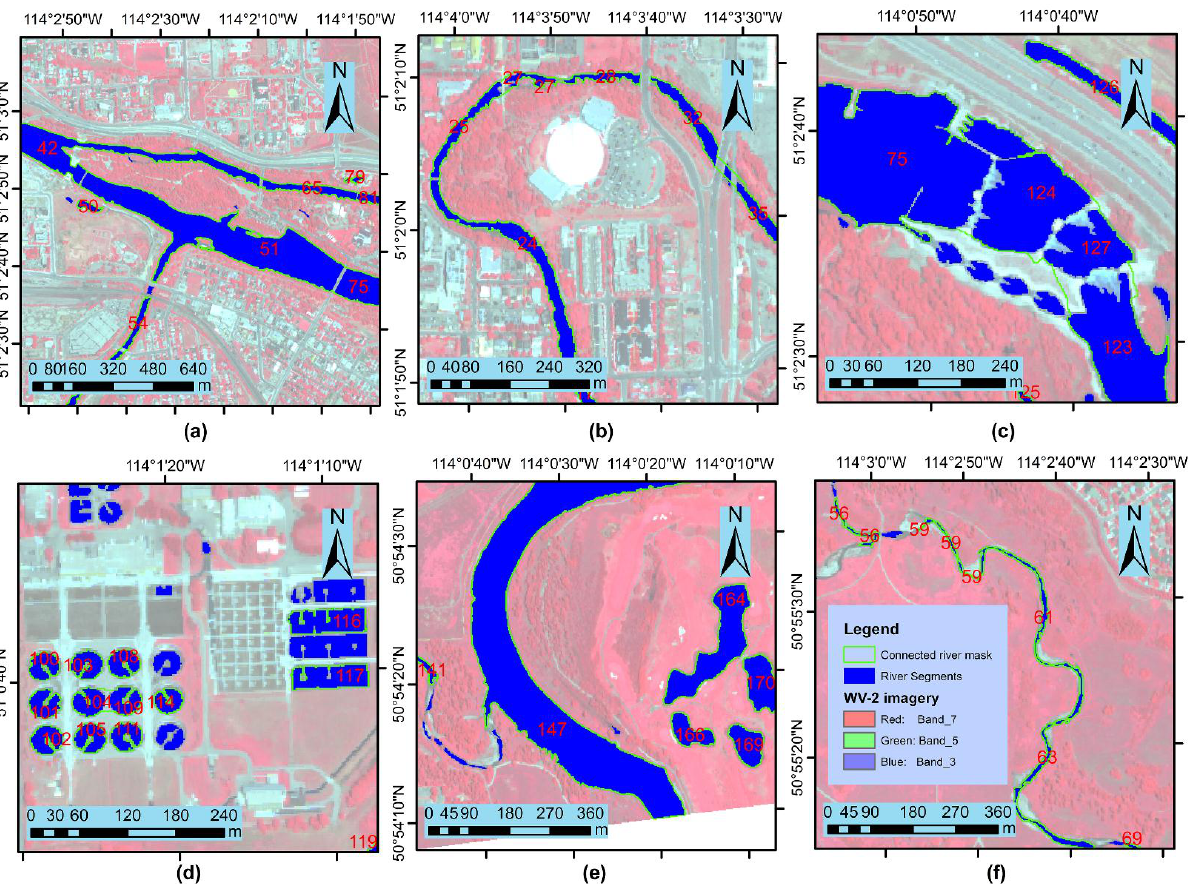
Figure 10. Six diverse cases of NRBC river detection. The blue extracted river segments are draped on the false-colour WV-2 imagery. The green polylines show the connected river boundaries after application of the NRBC algorithm. ( a ) Typical river segments that are successfully connected; ( b ) Connection at a narrow stream; ( c ) A complicated segment connection case at the dam; ( d ) and ( e ) Ponds are not connected based on minimum segment length rule; ( f ) The narrowest upstream misses some connections due to input water mask